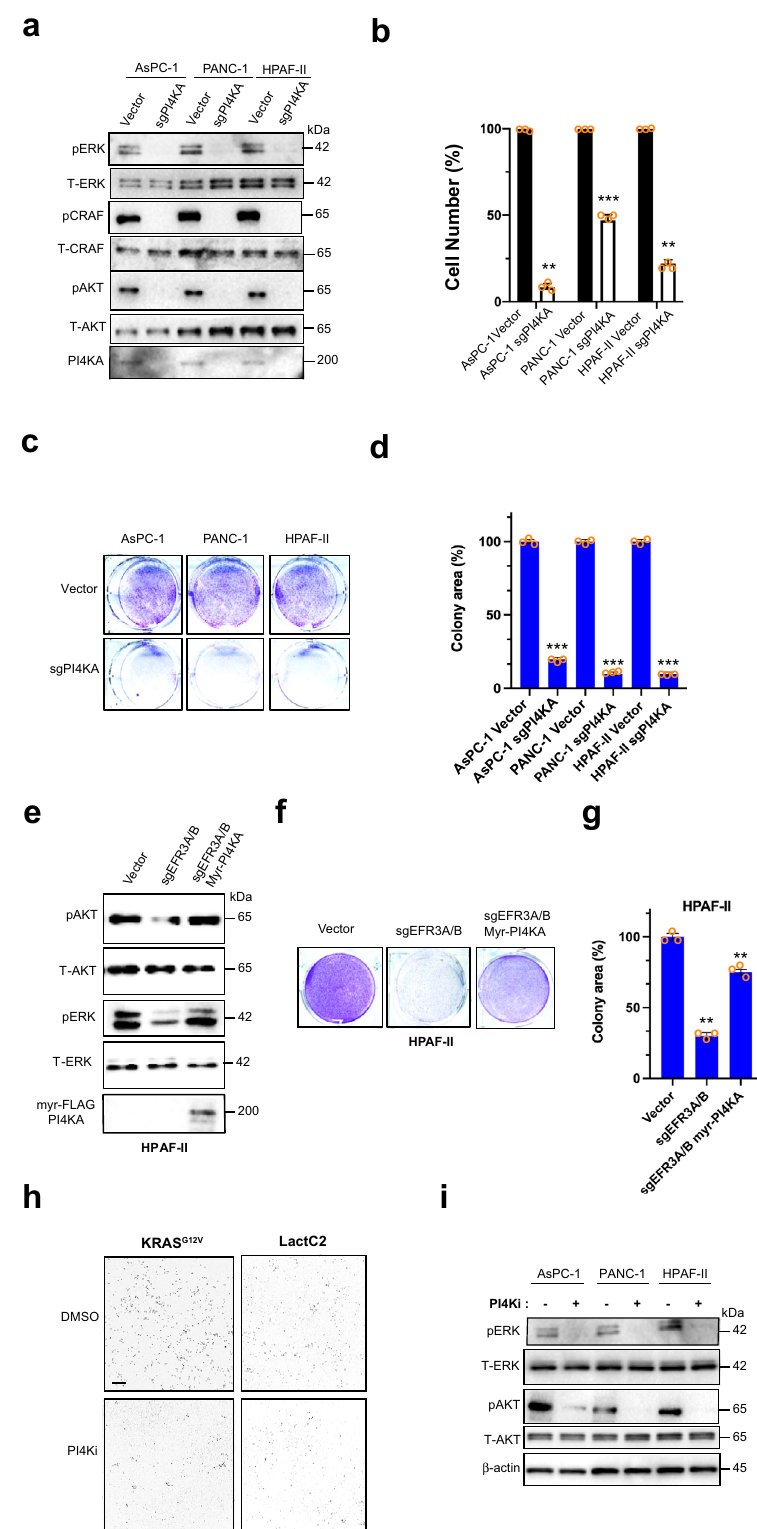
human pancreatic adenocarcinoma cell lines AsPC-1, PANC-1, (Fig. 9a), cell number over time (Fig. 9b), 2D- (Fig. 9c, d), and and HPAF-II were stably transduced with a vector encoding Cas9 3D- (Supplementary Fig. 9a) transformed growth in all three cell in the absence (vector control) and presence of an sgRNA tar- lines. Given these results, we next performed epistatic analysis by geting the PI4KA gene ( sgPI4KA ), which was con fi rmed by testing whether tethering PI4KA to the plasma membrane could immunoblot to reduce endogenous PI4KA levels (Fig. 9a). The rescue the loss of endogenous oncogenic KRAS signaling and loss of PI4KA also reduced P-AKT, P-ERK, and P-CRAF levels transformation in EFR3A/B-knockout cells. To this end, HPAF-II NATURE COMMUNICATIONS| (2021) 12:5248